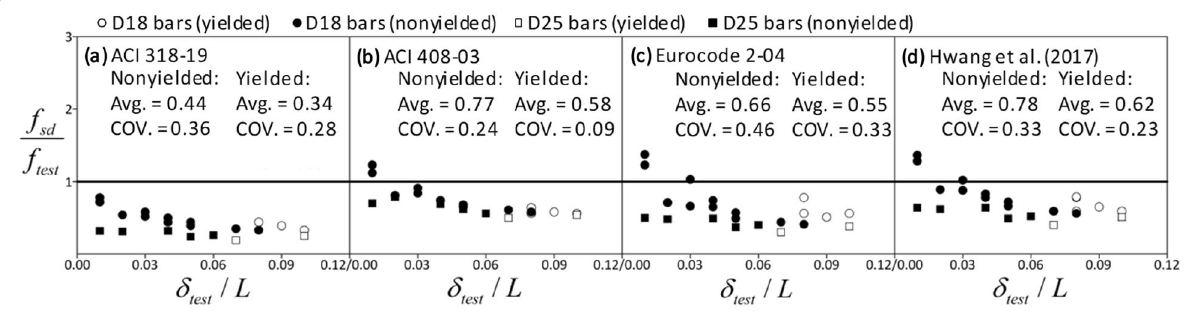
Fig. 12 Comparison of tested bar stress with predictions using strain rate effect on concrete tensile strength (with cover concrete loss).